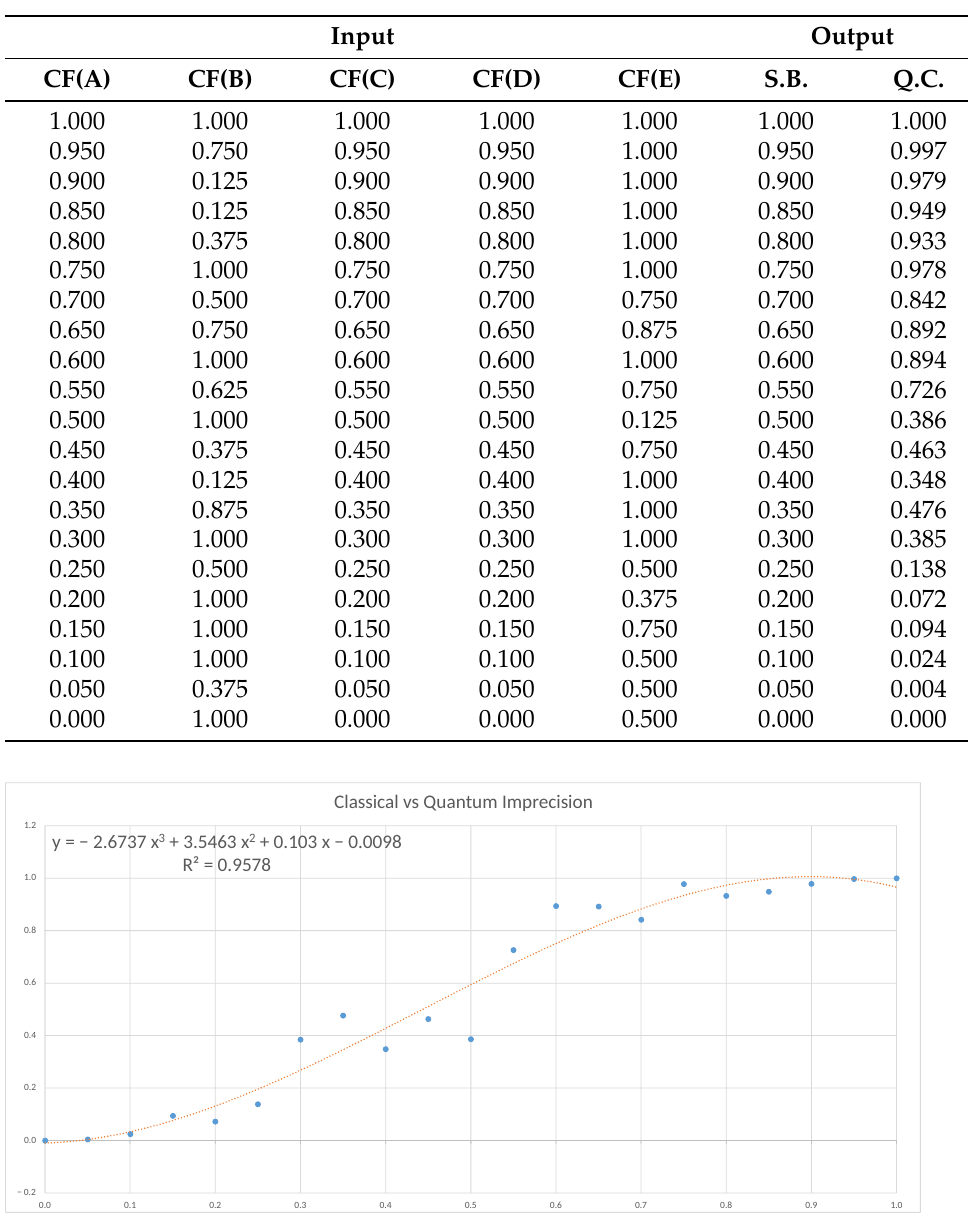
Table 7. Inputs and outputs for the imprecision experiment.